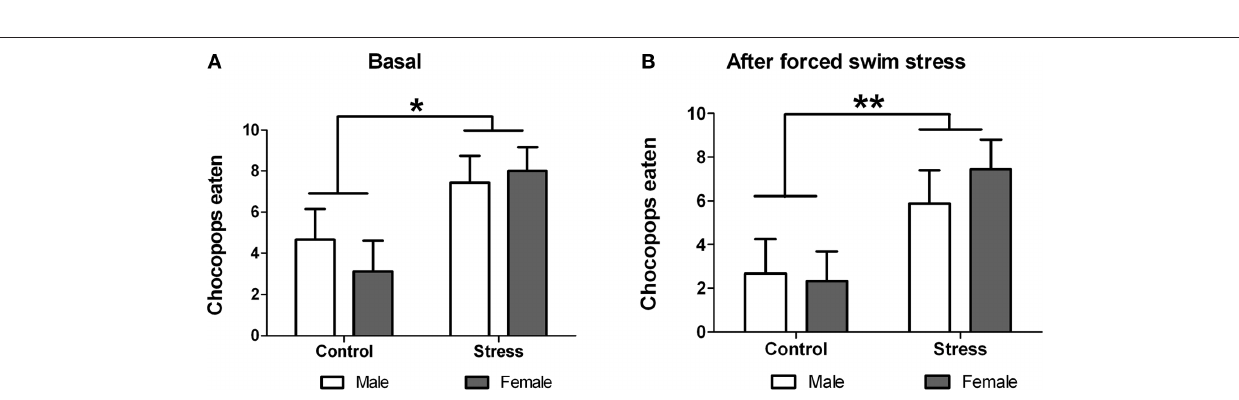
Figure 6 | effect of peri-pubertal stress on behavior at the chocopop pellet test. Mean (SEM) number of Chocopop pellets eaten by male and female rats that underwent either peri-pubertal stress (Stress) or no stress (Control) in their home cage (a) or immediately after stress (B) . * p < 0.05 treatment effect; ** p < 0.01 treatment